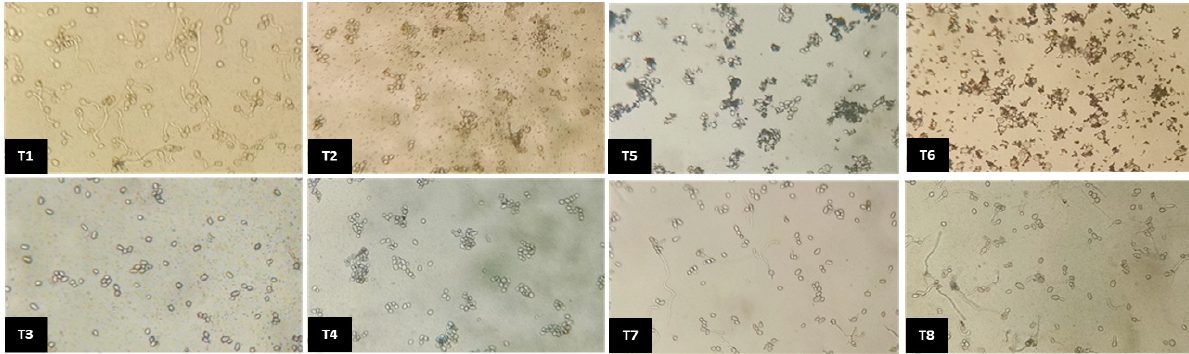
Figure 3. Effect of chemical and biological fungicides on conidial germination after 24 hours. Conidial solution on water was used. La Molina, 2015..